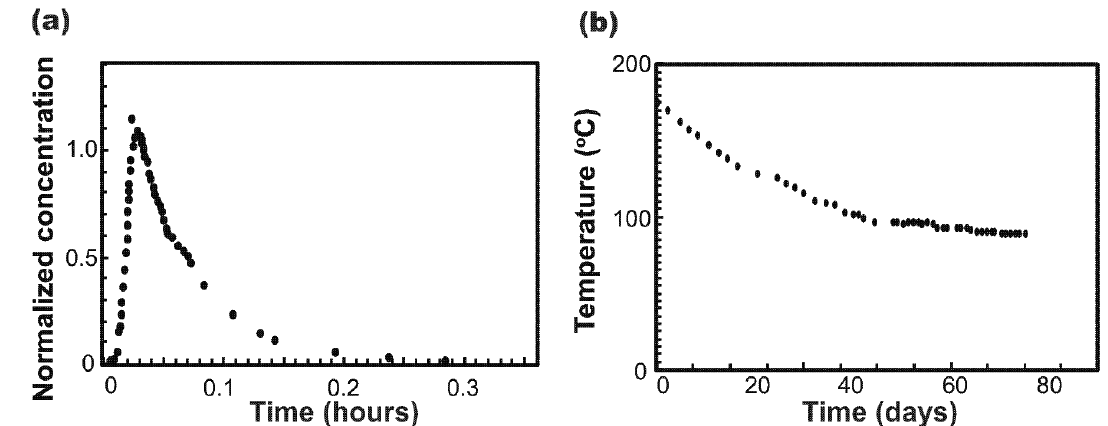
Figure 6. Field data from Fenton Hill HDR reservoir. ( a ) tracer response and ( b ) temperature decline curves [23].